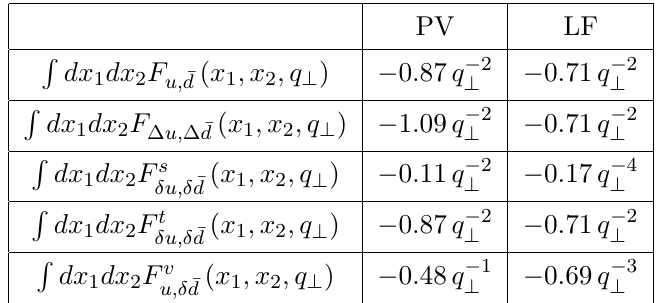
( x 1 ; x 2 ; q ? ), for q ? 1 ; (cid:22) a